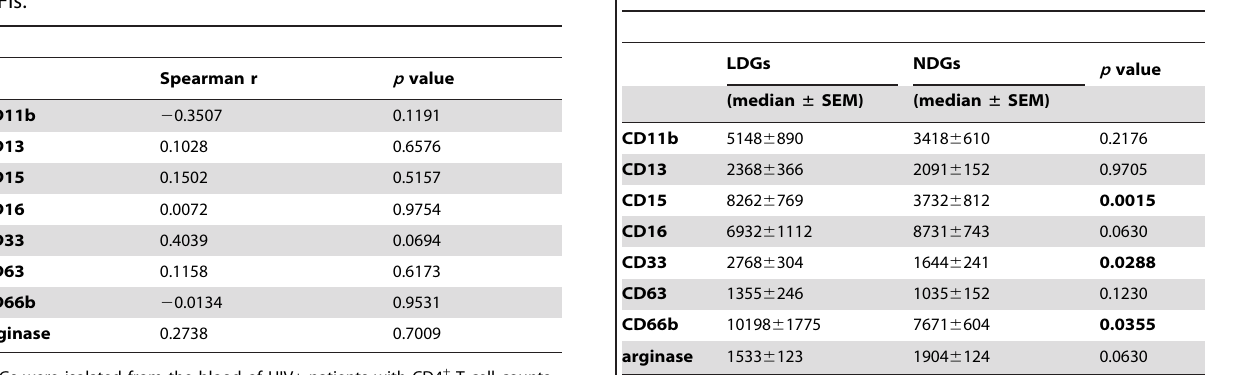
Table 8. LDGs and NDGs in HIV + patients in CD4low HIV +